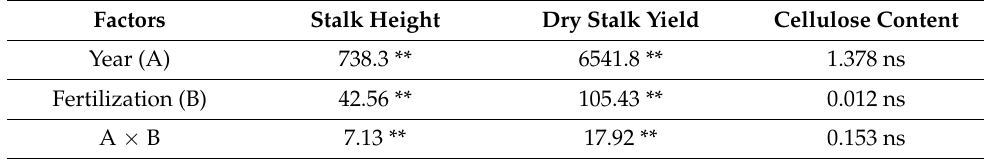
Table 7. Two-factor analysis of variance of examined